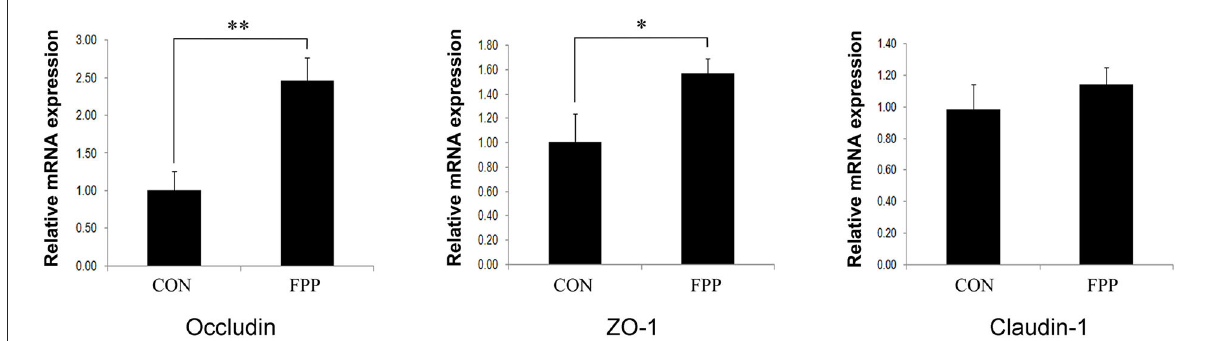
FIGURE2 Relative abundance of tight junction proteins Occludin , ZO-1 , and Claudin-1 mRNA in the jejunum of laying hens-fed basal diet supplemented with 0 (CON) and 500 mg/kg of the fermented plant product (FPP). β -actin was selected as an internal control. Data are shown as means and standard error ( n = 8). * P < 0.05, ** P <